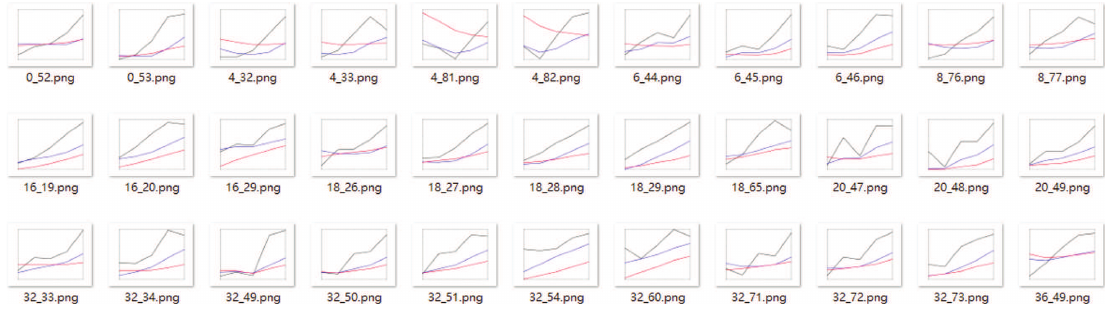
Figure 24: Experiment 2 with Label